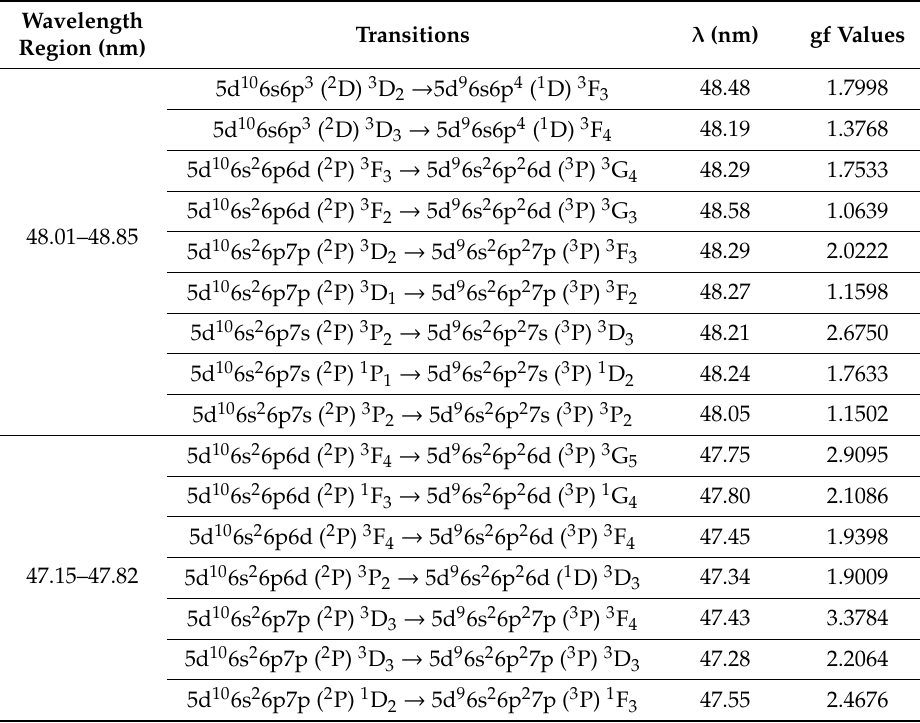
Table 2. Transitions arising from lowly lying (excited) electron configurations of Bi +